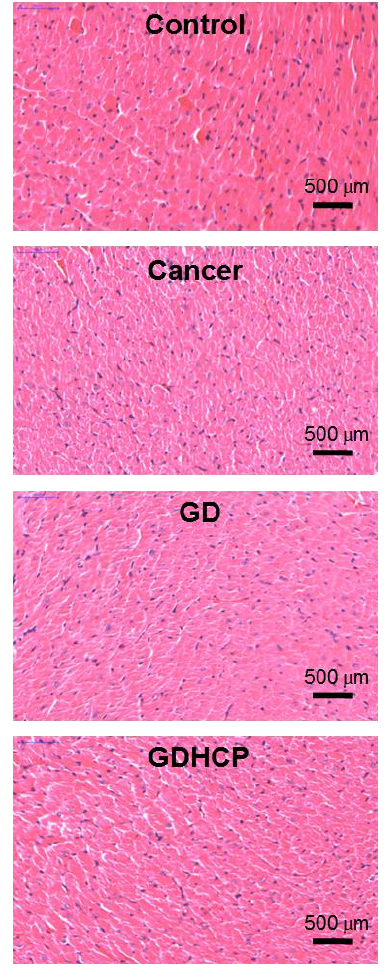
Figure 7. H&E stained slides of heart tissues extracted from control, cancer bearing, GD- and GDHCP-treated mice after 4 weeks. The slides were observed at 4×. The scale bars indicate 500 µm.